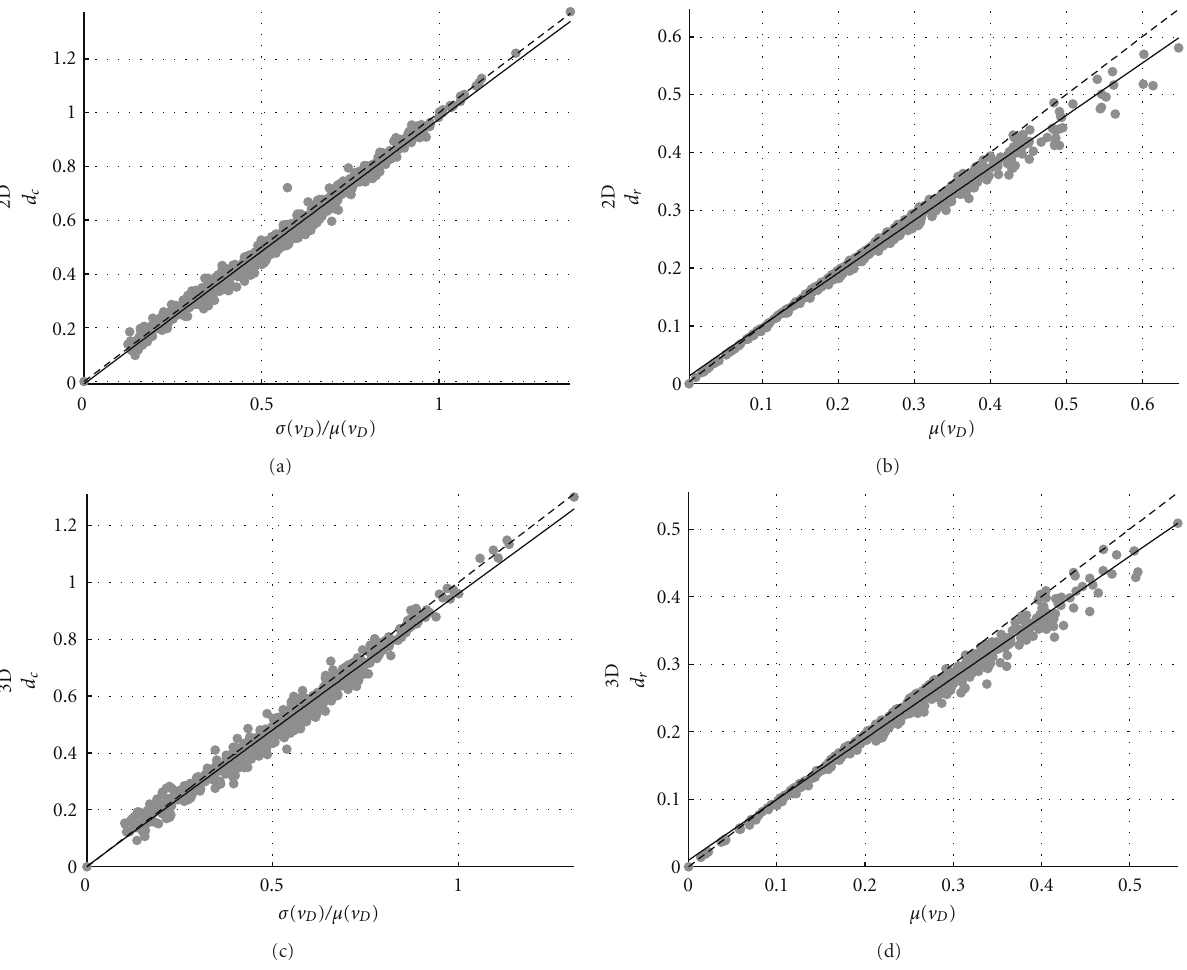
Figure 3: (a, c) d c versus σ ( v D ) /μ ( v D ) and (b, d) d r versus μ ( v D ) for all the 625 tests of the (a, b) 2D and (c, d) 3D training sets. A linear fit was performed for both scatter plot types (continuous line) showing the quasi-one-to-one relationship between the theoretical values σ ( v D ) /μ ( v D ), μ ( v D ) and their estimates d c and d r . The one-to-one relationship is represented by the dashed